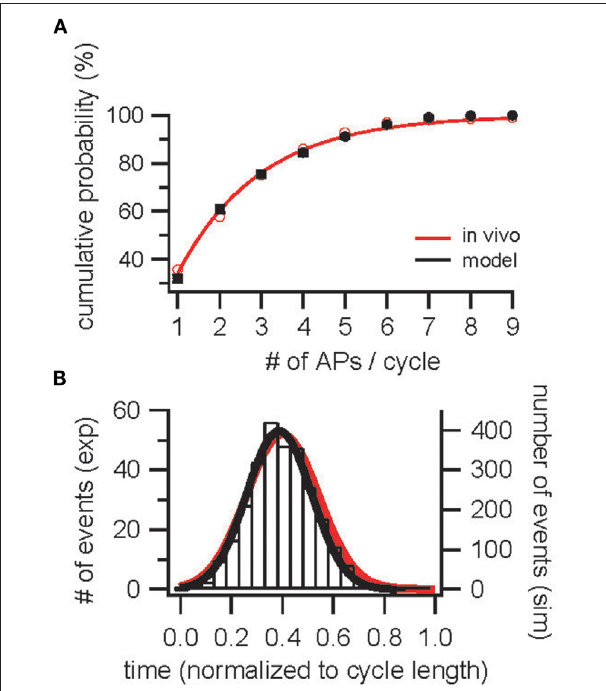
FIGURE 2 | Construction and validation of an OB model based on parameters determined in vivo —population constraints. (A) Cumulative probability for the occurrence of 1–9 APs per sniff cycle during odor-evoked AP discharge in InF neurons ( black ) and in vivo [red; Margrie and Schaefer (2003)]. (B) Distribution of APs across a sniff cycle in simulation ( black ) and in vivo [ red , Margrie and Schaefer (2003)].